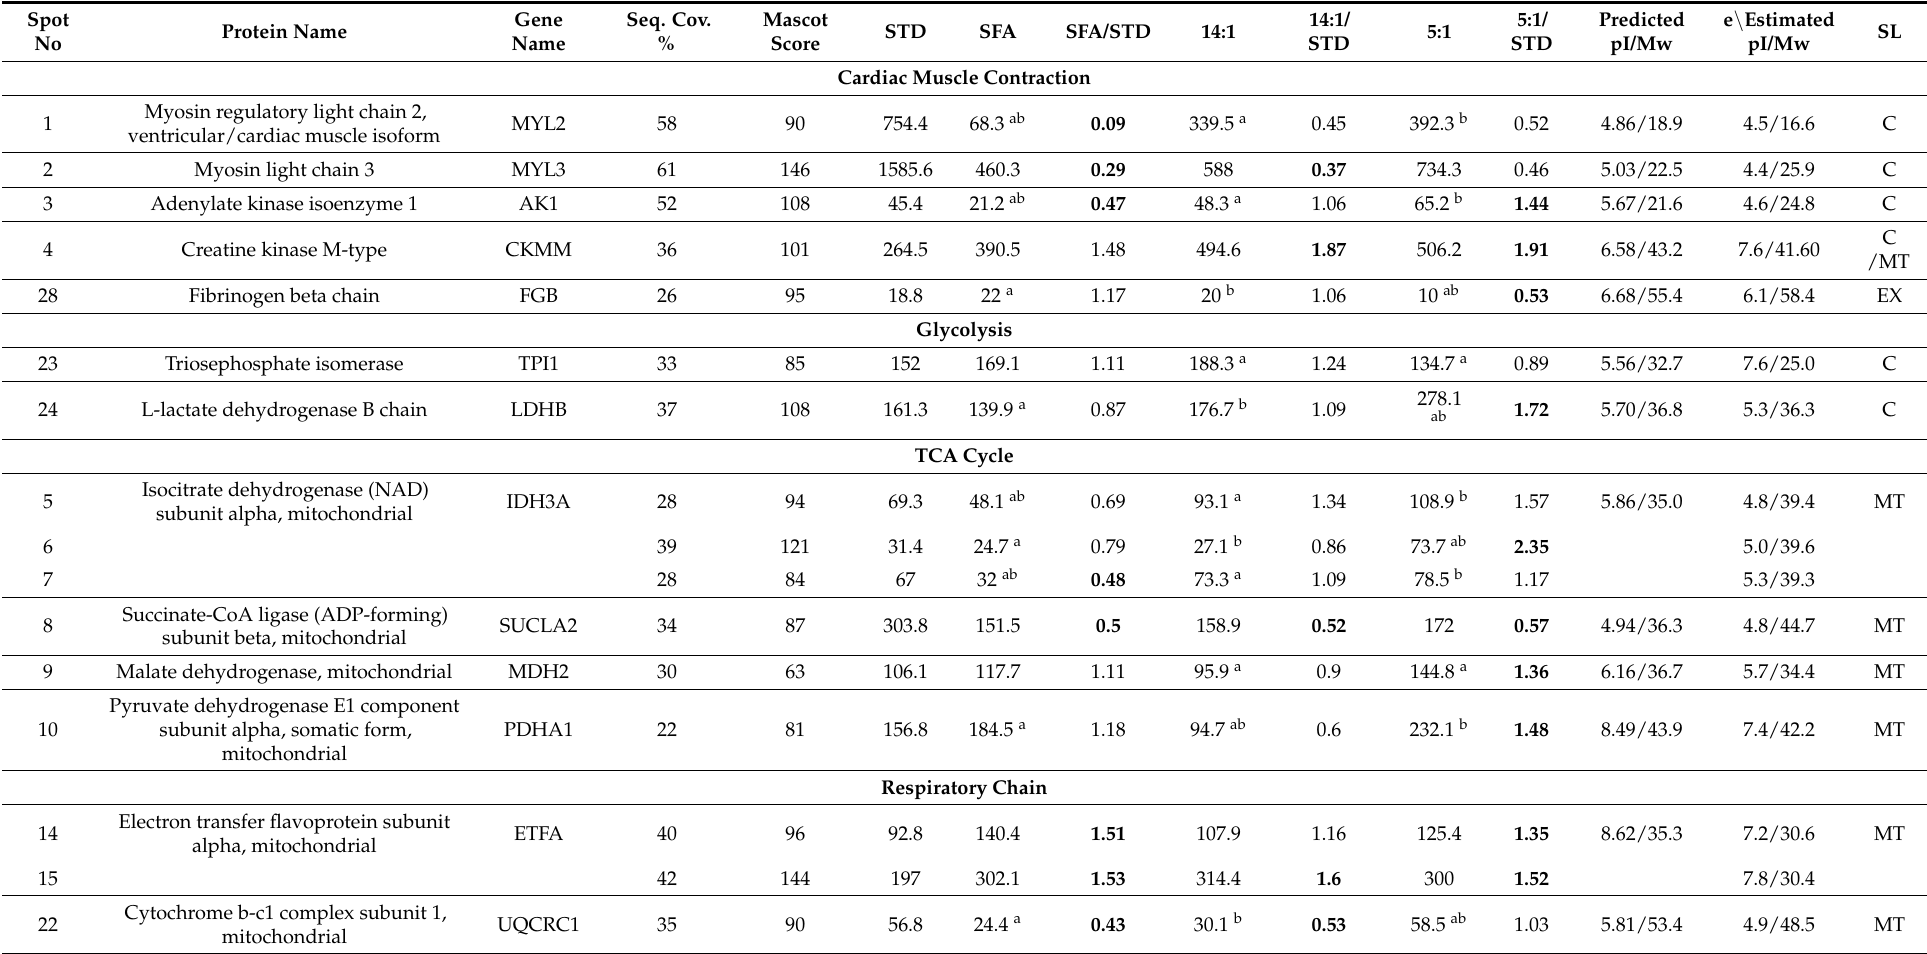
Table 3. Differentially expressed protein spots between the standard (STD) and high-fat diet groups (SFA, 14:1, 5:1) in mouse cardiac muscle. Proteins were grouped according to their known biological processes. Spot numbers in the table correspond to the numbers in Figure 1 (2-DE proteome map) and Figure 3 (Heat